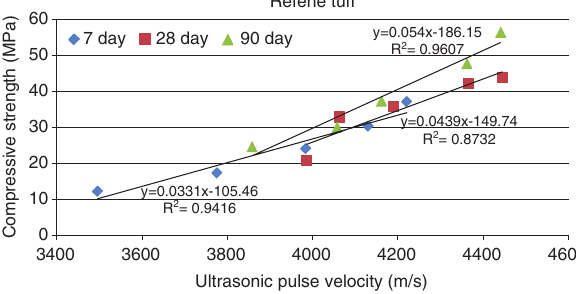
Figure 7 Relationship between ultrasonic pulse velocity and com- pressive strength of samples for Refene tuff.